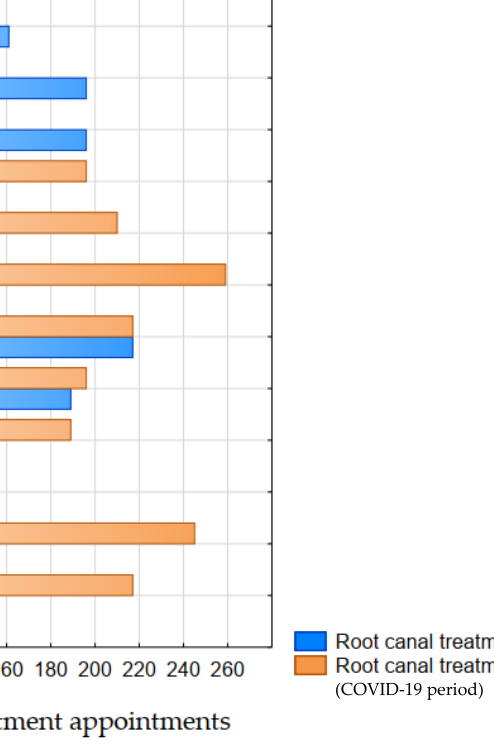
Figure 7. Change in the number of root canal treatment appointments during the pandemic period from the prepandemic period.